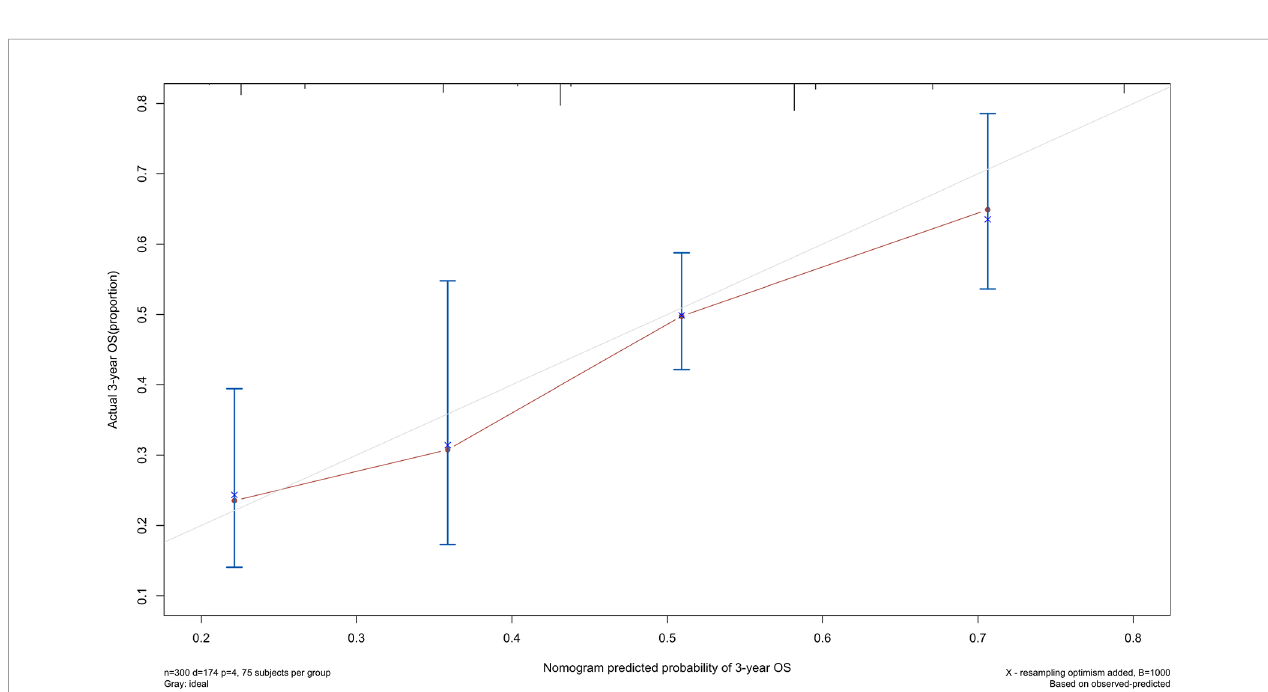
FIGURE 3 | Calibration curve for nomogram of patients with Siewert type II/III